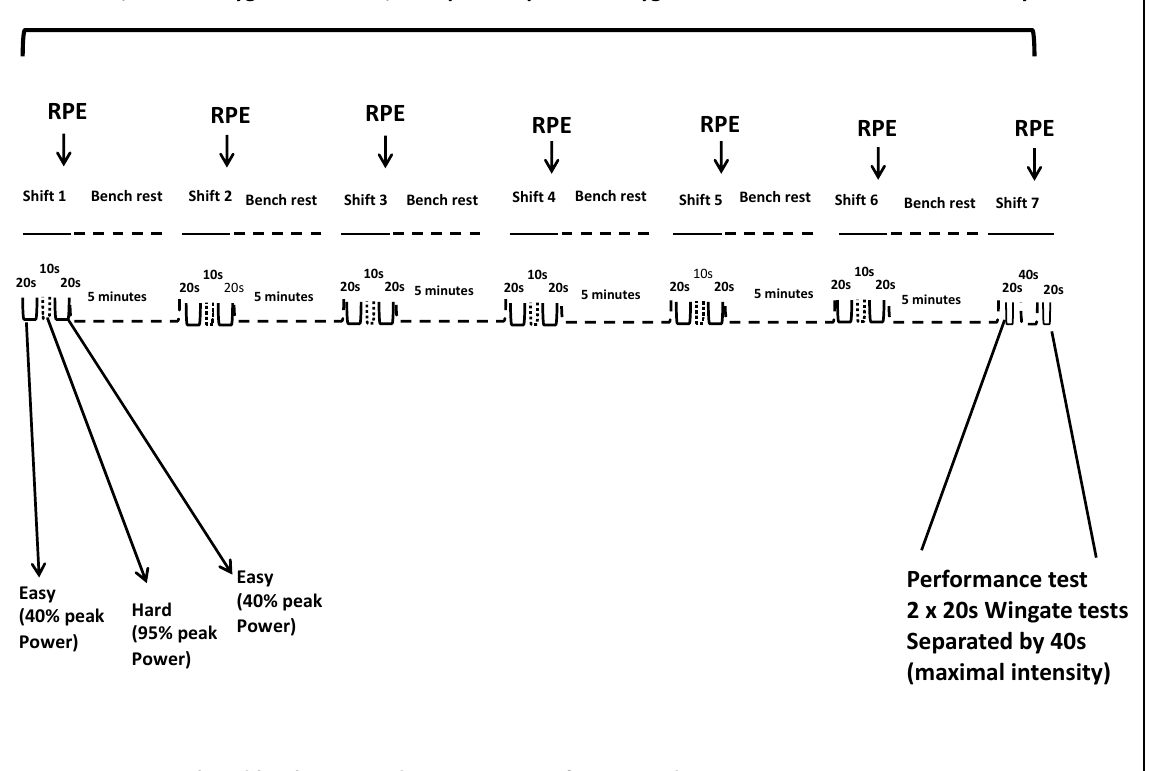
Figure 2. Simulated hockey period; RPE = rating of perceived exertion; HR = heart rate; SpO 2 = atrial oxygen saturation. During sessions three and four, heart rate and arterial blood oxygen saturation were